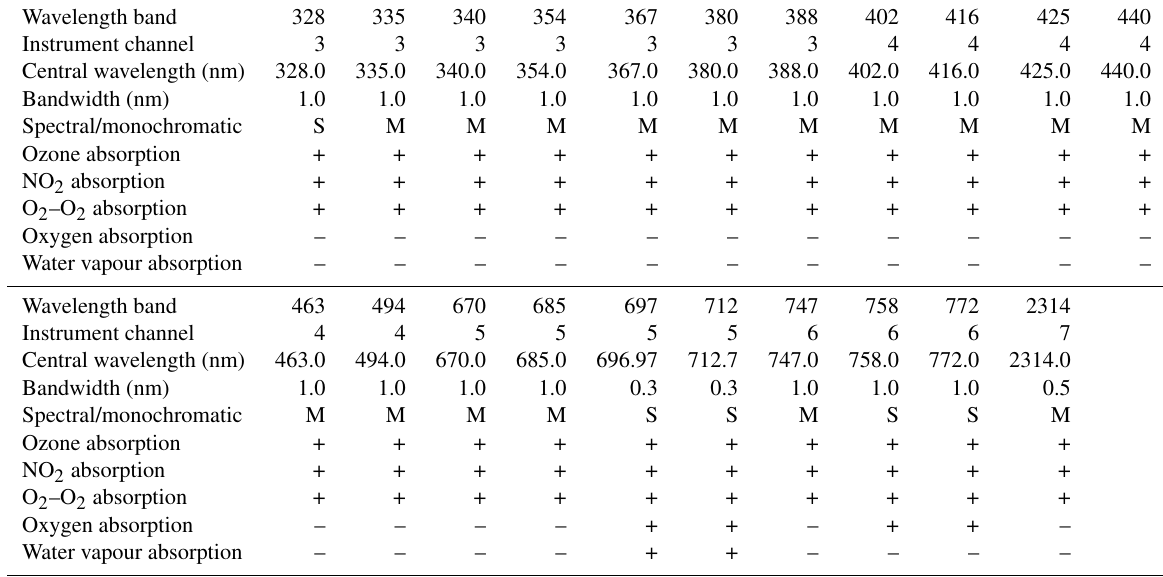
Table 2. Definition of the wavelength bands and of the way the radiative transfer calculations were performed. Wavelength band Instrument channel